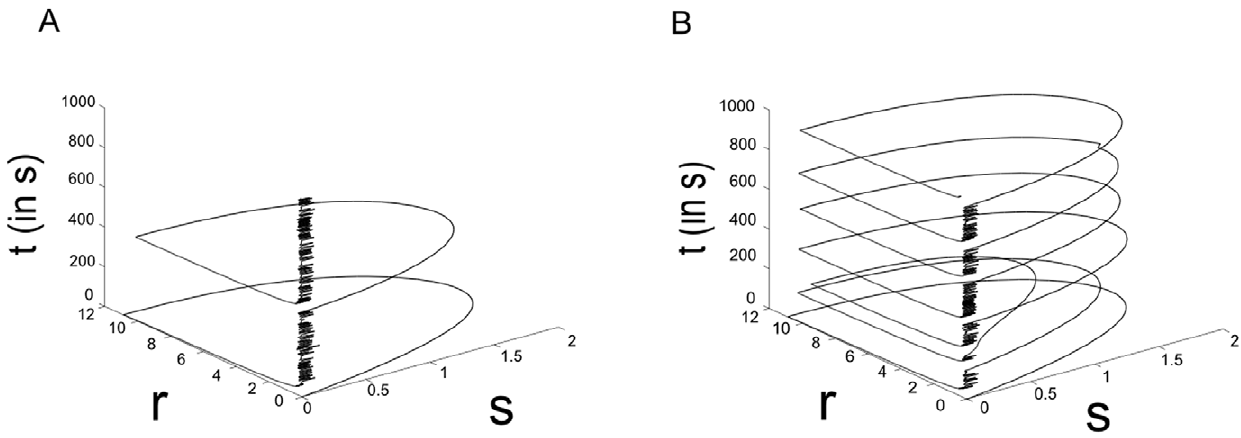
Figure 5. Single cell dynamics of a model SAC when setting B R in (8) low (A), and high (B), to .09 and .095, respectively. Shown are the dynamics of a single cell in a full simulation of the model retina over 1000 seconds. Here, s is the firing rate of the model SAC, and r the amount of inhibition due to intracellular processes. By setting B R high, the decay rate of inhibition decreases, analogous to the application of forskolin to acute retinal slices. This has the effect of increasing both the WPM and the wave velocity (see Figure 4).